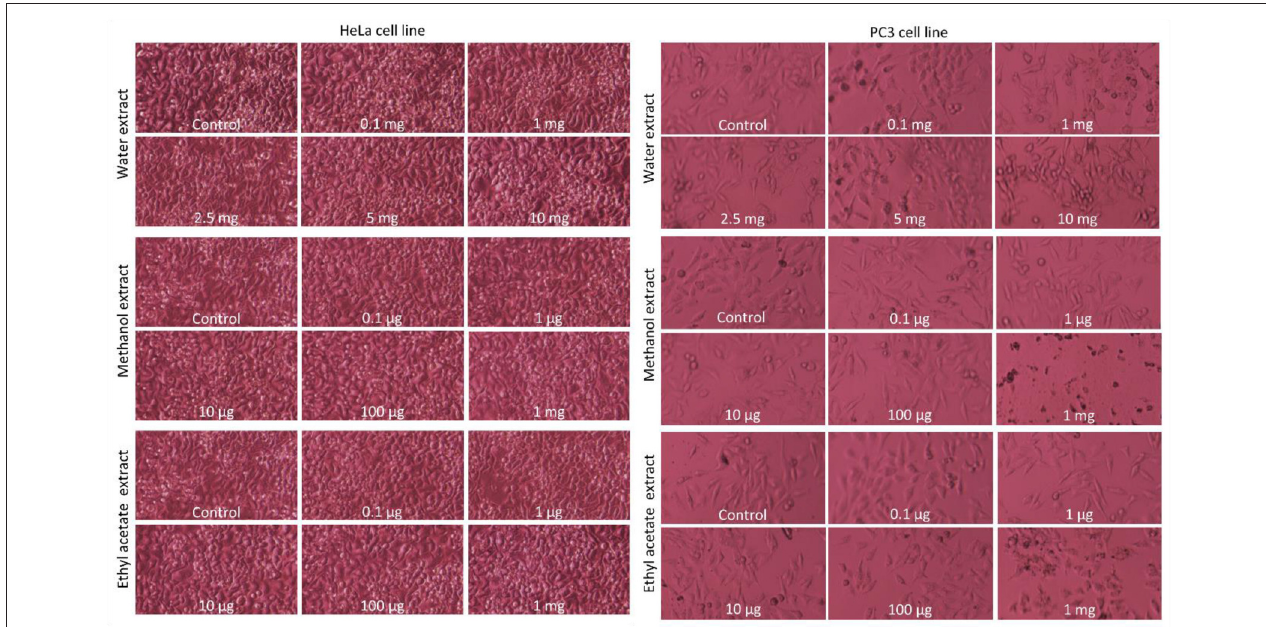
FIGURE 6 | Cells morphology of HeLA and PC3 cancer cell lines after application of different extracts of Ononis natrix. Control and different concentrations of extracts were tested in HeLA or PC3 cancer cell lines and indicated for each figures.